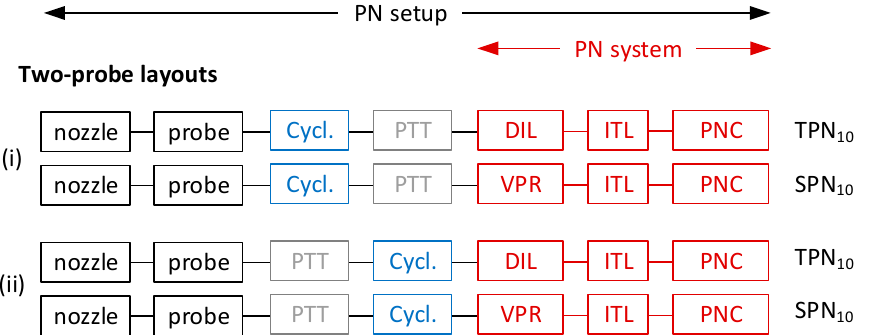
Figure 1. Particle number (PN) setup parts and layouts with two-probe. PN system in red (three last red boxes). The one-probe layout can be found in the Appendix A. Cycl. = cyclonic separator; DIL = diluter; ITL = internal transfer line; PNC = particle number counter; PTT = particle transfer tube; Split. = flow-splitting device; VPR = volatile particle remover.